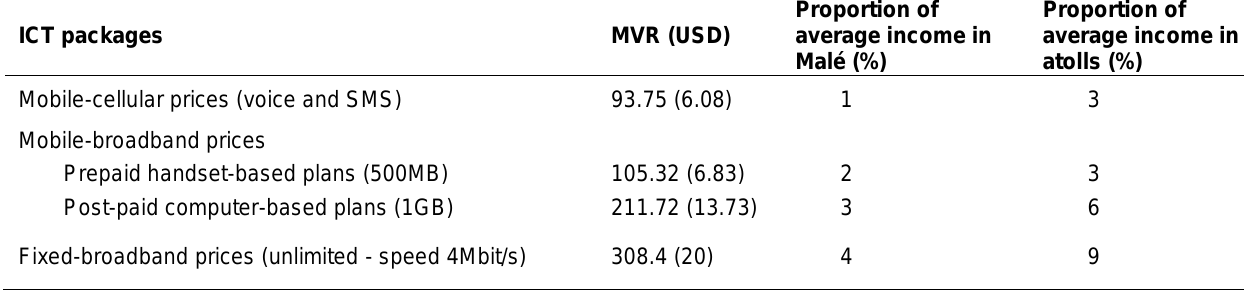
Table 4. ICT Prices and Prices as a Proportion of Monthly